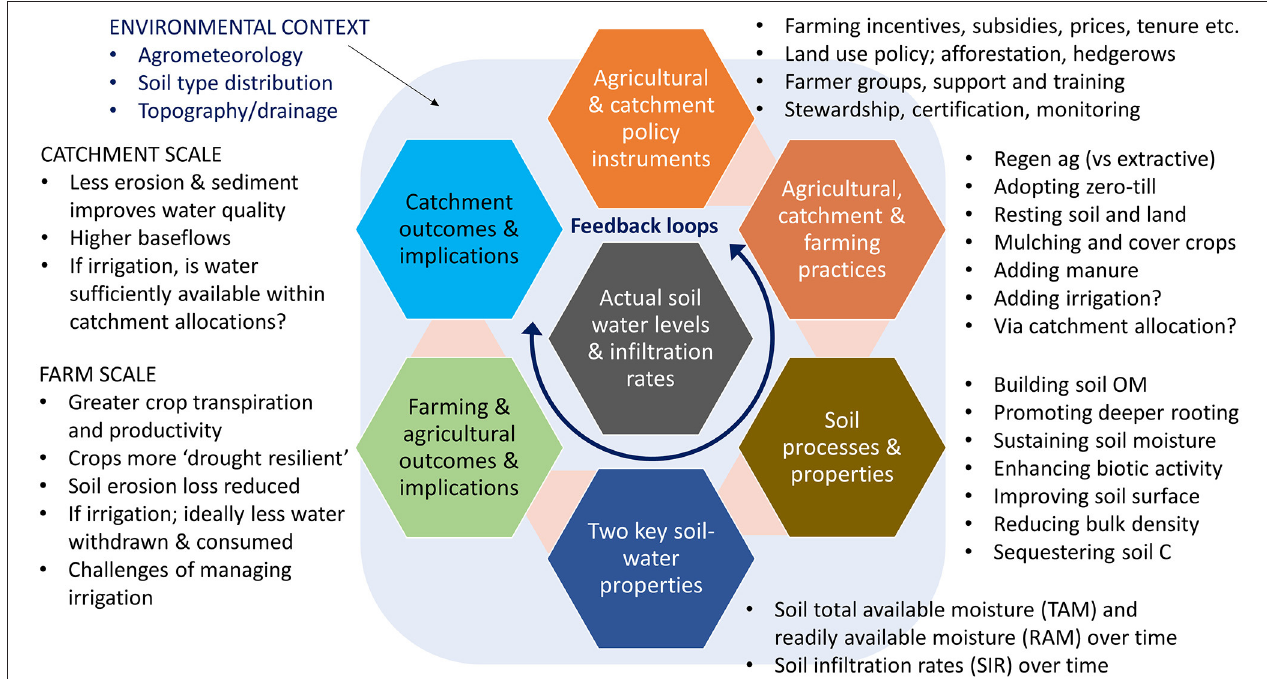
FIGURE 4 | An interconnected system of factors influence RAM and SIR and their RA outcomes.